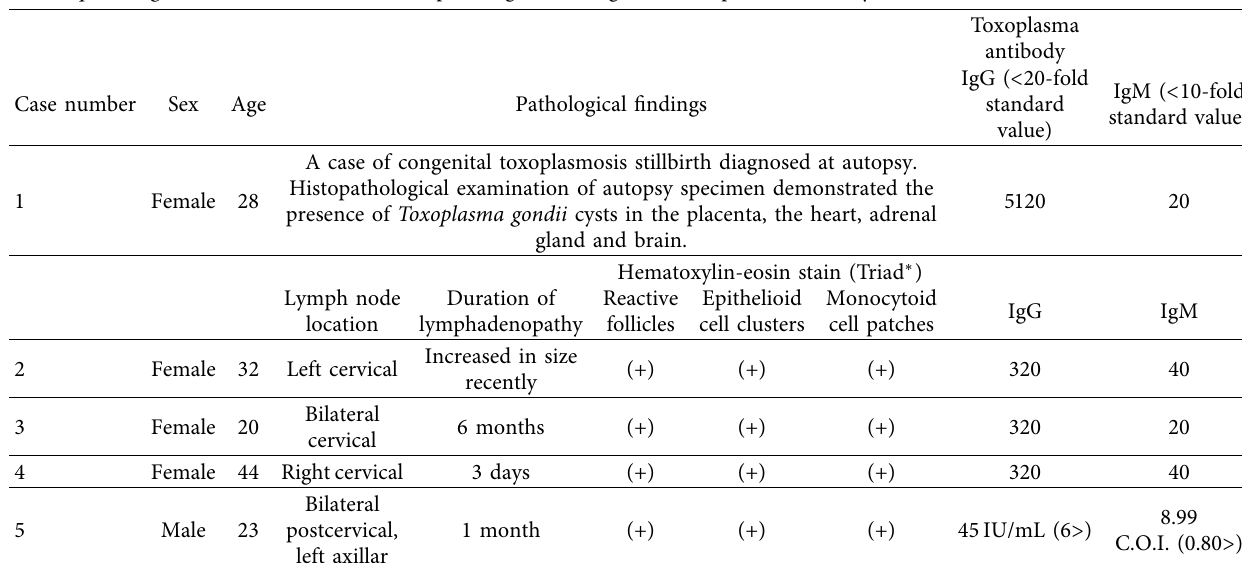
Table 1: One clinically diagnosed congenital toxoplasmosis case (case 1) and toxoplasmosis lymphadenopathy cases (cases 2–5) suspected to be Toxoplasma gondii infections based on the pathological findings and Toxoplasma antibody